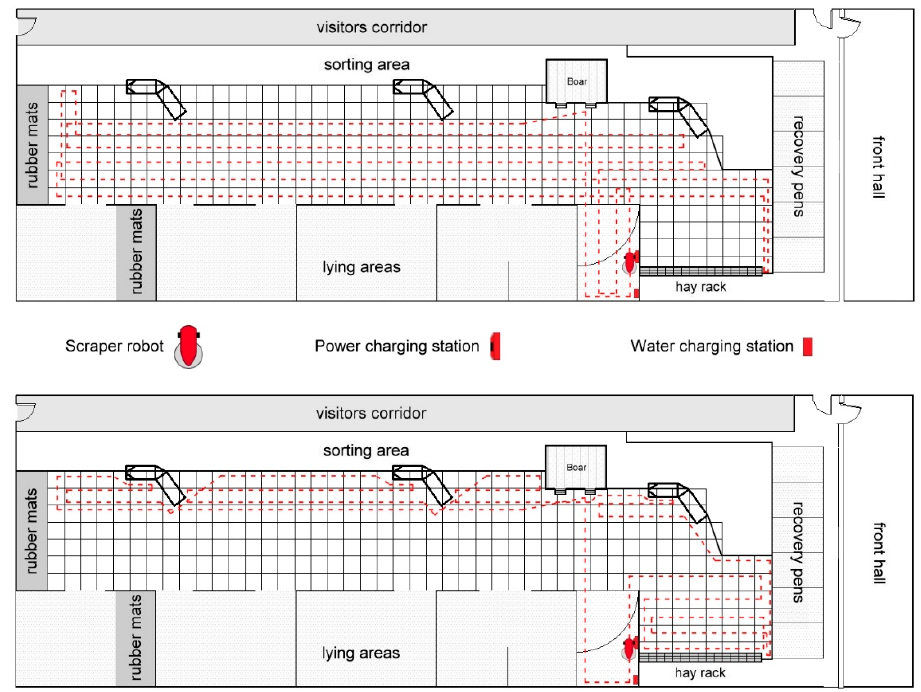
Figure 2. Score-squares for evaluation of cleaning performance and routes of the robot scraper determined in the activity area. Route 1 (above) and route 2 (below) were executed one immediately after the other. The icons of the scraper robot and charging stations originate from Lely Holding S.à.r.l.